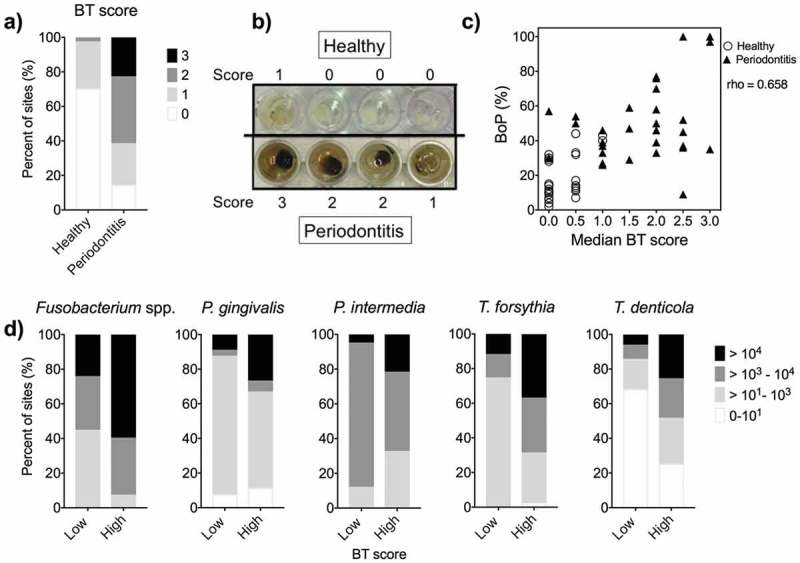
The results from the bismuth test (BT).(a) The bismuth test score of all sites is illustrated in the bars for healthy and periodontitis groups. The median of four sites/subject was 0 (range 0–1) for the healthy group and 2 (range 0–3) for the periodontitis group. (b) The photo is showing the BT of a subject in the healthy group and one from the periodontitis group. (c) BoP and BT scores (median) were tested positive for the correlation (rho = 0.658, p < 0.0001) (O Healthy, ▲ Periodontitis). (d) The BT score (high/low) is shown in relation to the bacterial counts for the five bacterial species tested.